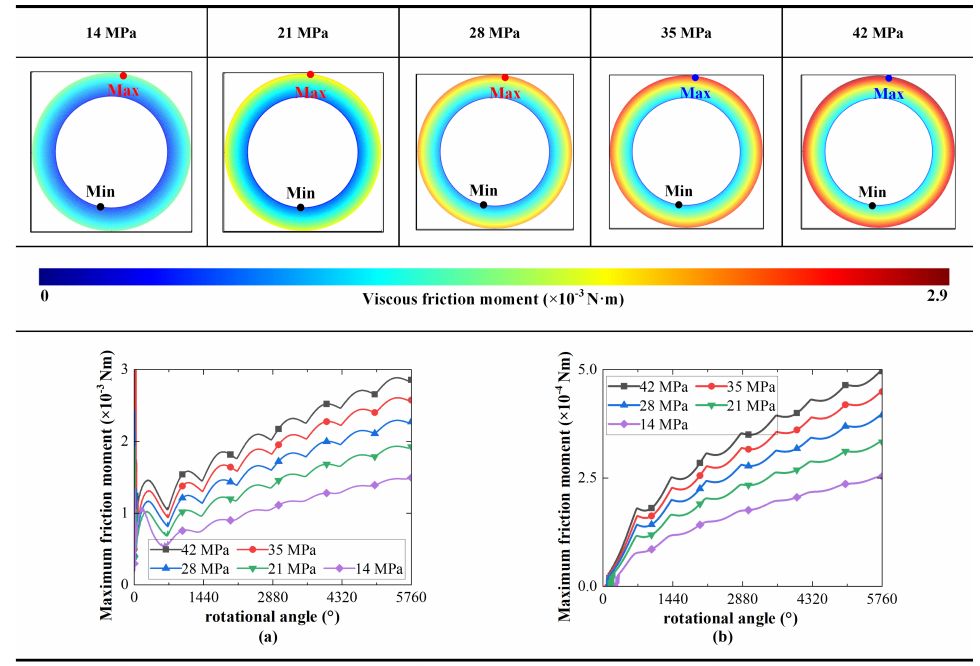
Figure 16. Viscous friction moment at different pressures. ( a ) Maximum friction moment at different pressures. ( b ) Minimum friction moment at different pressures.